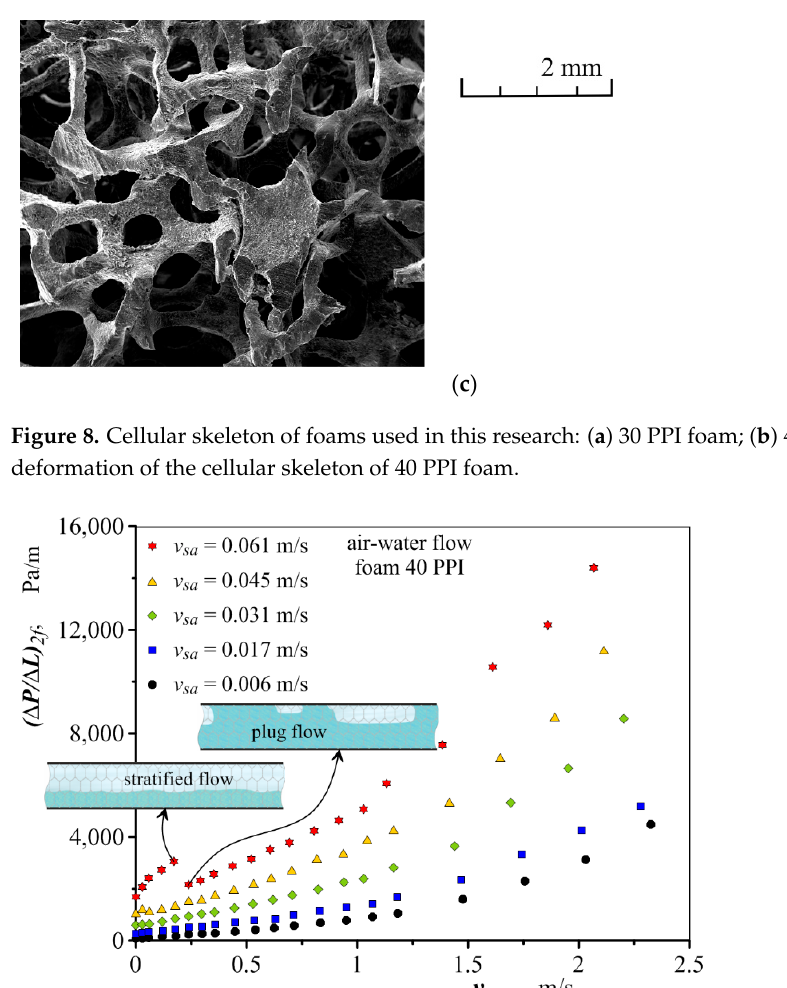
Figure 9. Measured pressure drop in the air–water flow as a function of the phase velocity (flow through 40 PPI foam channel)